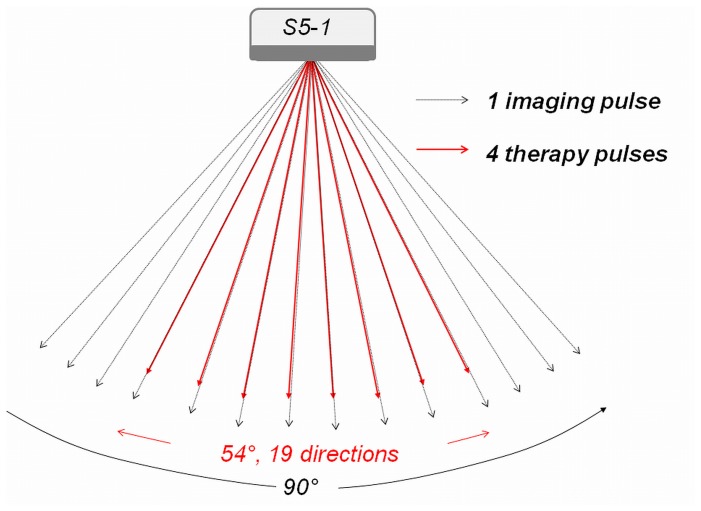
Depiction of the Modified Transducer for Thrombolysis.Schematic depiction of the modified diagnostic ultrasound transducer on the Philips S5-1 scanner. The therapeutic impulses were sent as ensembles of four pulses of the same length, while shorter B-mode pulses of lower amplitude were interleaved for background images of microbubble replenishment within the risk area.